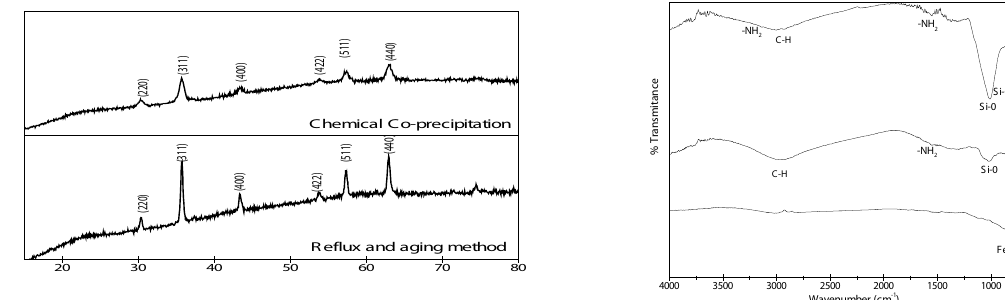
Figure 2. XRD of magnetite obtained by chemical coprecipitation and reflux and aging method.